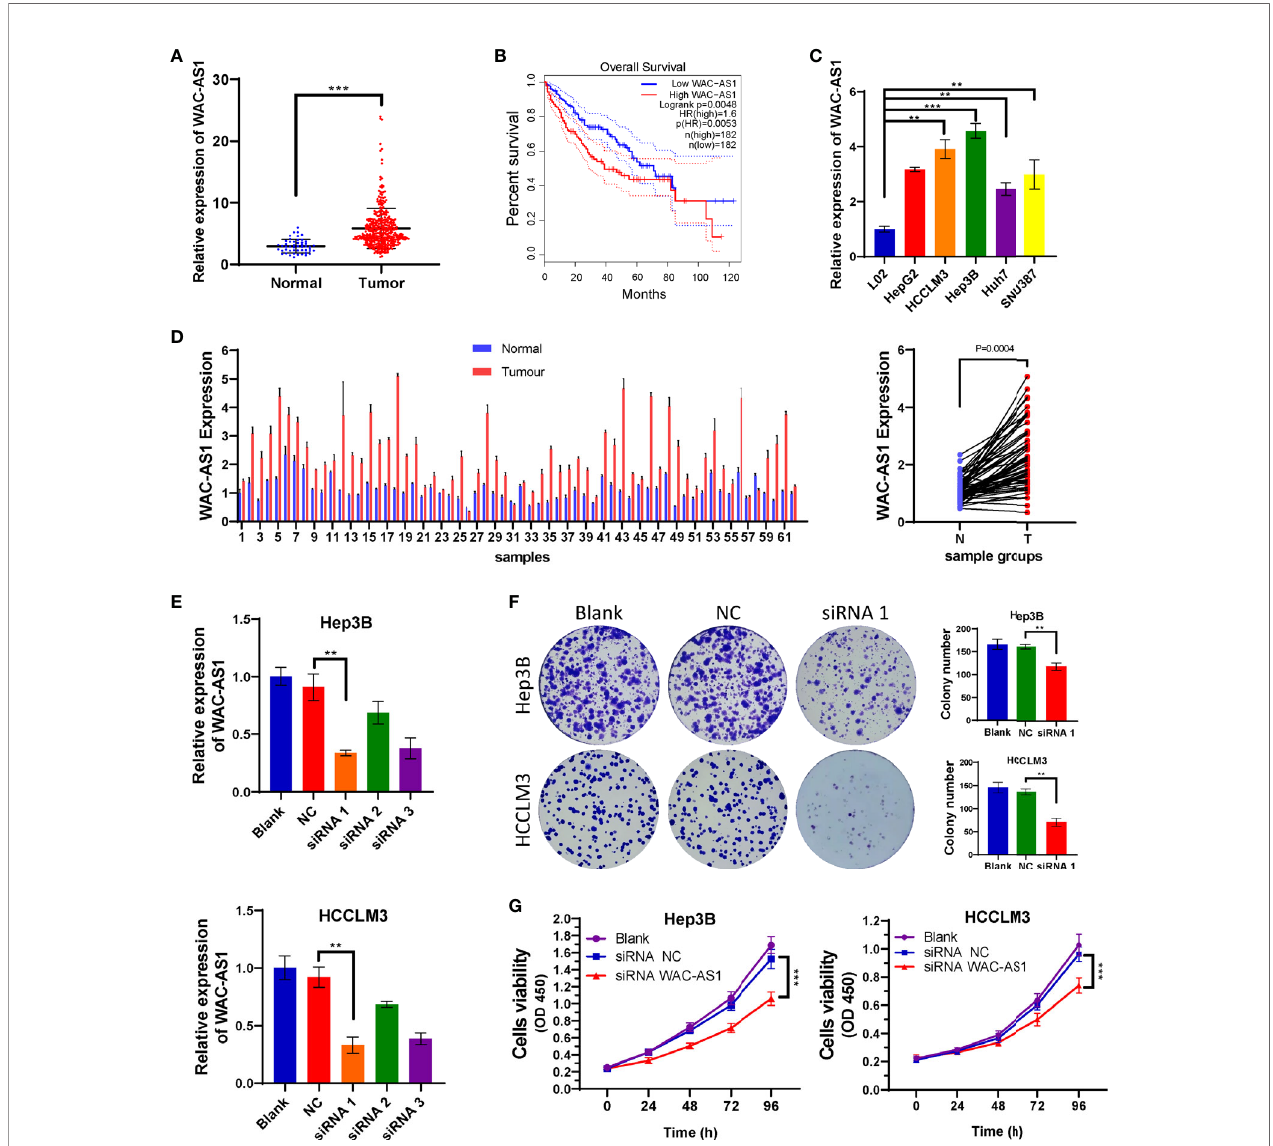
FIGURE 5 | High expression of WAC-AS1 is signi fi cantly correlated with a poor prognosis and cell proliferation; (A) expression of WAC-AS1 in patients of the TCGA cohort; (B) survival curves for patients in the TCGA cohort; (C) expression of WAC-AS1 in cells; (D) expression of WAC-AS1 in patients from Zhongnan Hospital; (E) siRNA-mediated knockdown of WAC-AS1; (F) representative images of plate colony formation in Hep3B and HCCLM3 cells; (G) CCK-8 assay for cellular viability. ∗∗ P < 0.01; ***p <